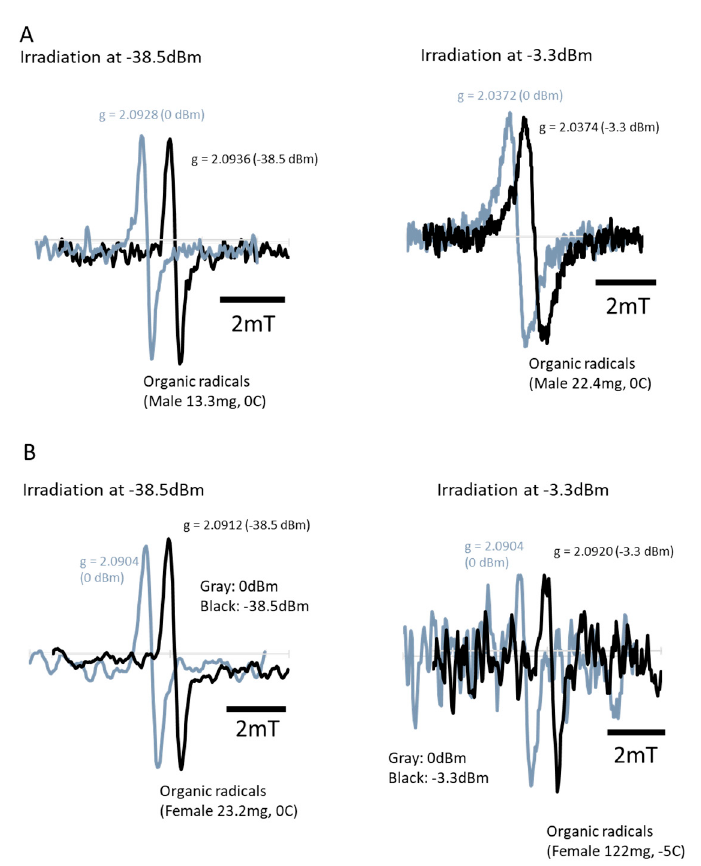
Figure 5. ESR spectra of organic radicals in the fruit flies, D. melanogaster . ( A ) ESR spectra of organic radicals in male fruit flies, D. melanogaster showing a decrease of free radicals under micro wave exposure of 2.45 GHz at − 38.5 dBm, − 3.3 dBm (black), and 0 dBm (control, no irradiation, grey); ( B ) ESR spectra of organic radicals in female fruit flies showing an increase under microwave exposure of 2.45 GHz at − 38.5 dBm, − 3.3 dBm (black), and 0 dBm (control, no irradiation, grey).